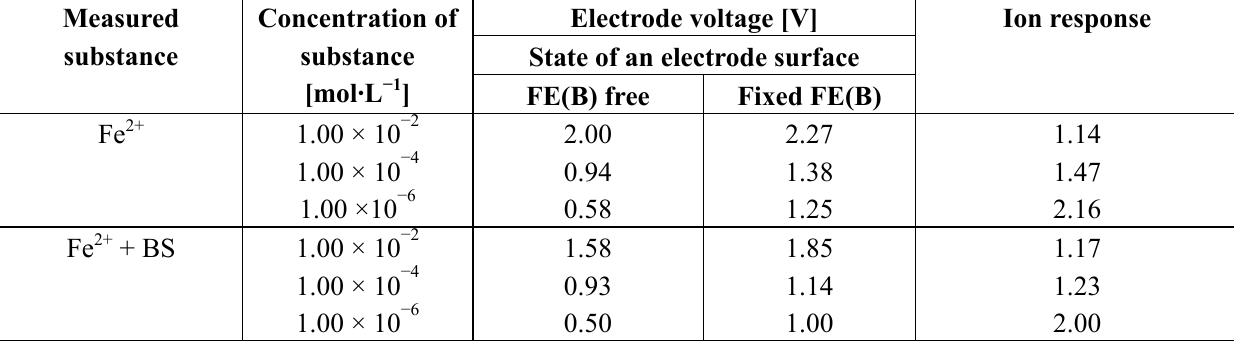
(4) Detection of Fe 2+ by FE(B) fixed on an electrode.